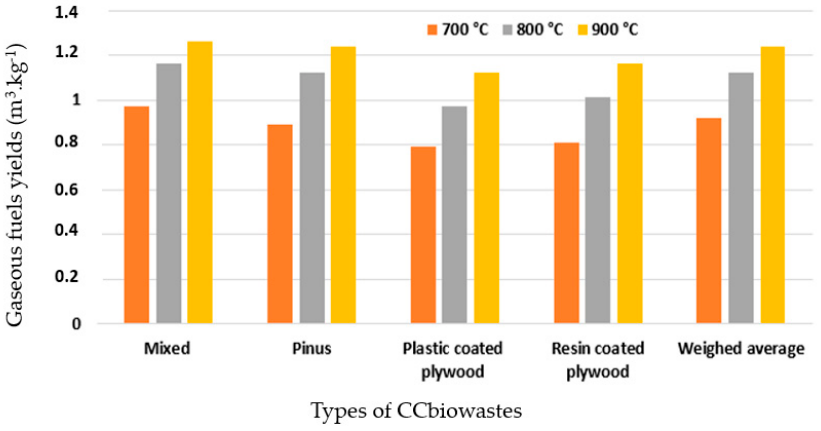
Figure 3. Effect of the gasification temperature on the gaseous fuel yields.